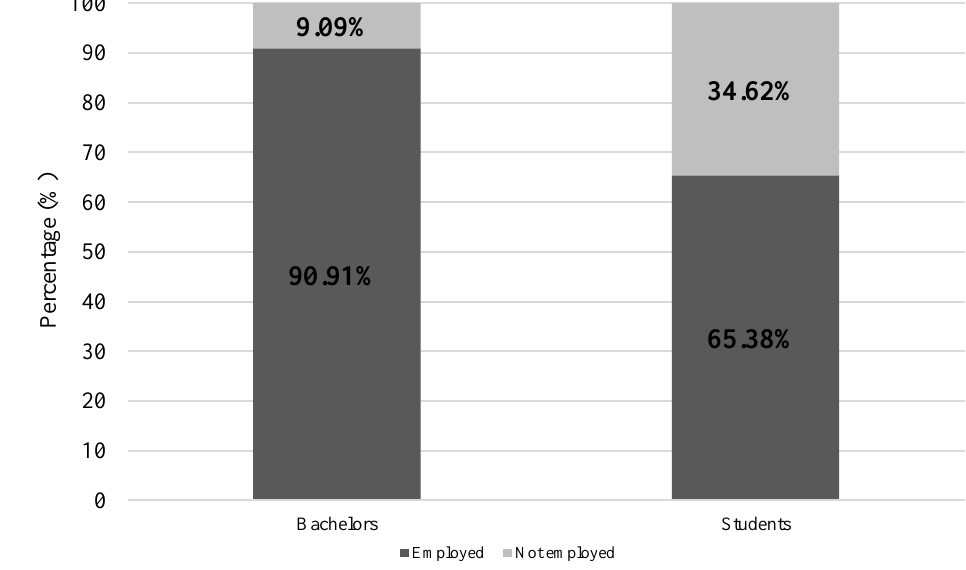
Figure 5. Percentage of employed B.S. graduates (December 2021) and students (July 2022) from the civil engineering program.